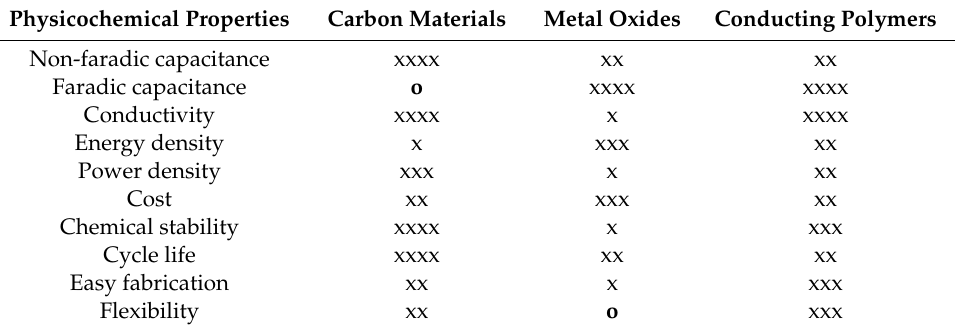
Table1. Comparisonbetweenthephysicochemicalpropertiesofbasematerialsusedinthesupercapacitor. Adapted from reference